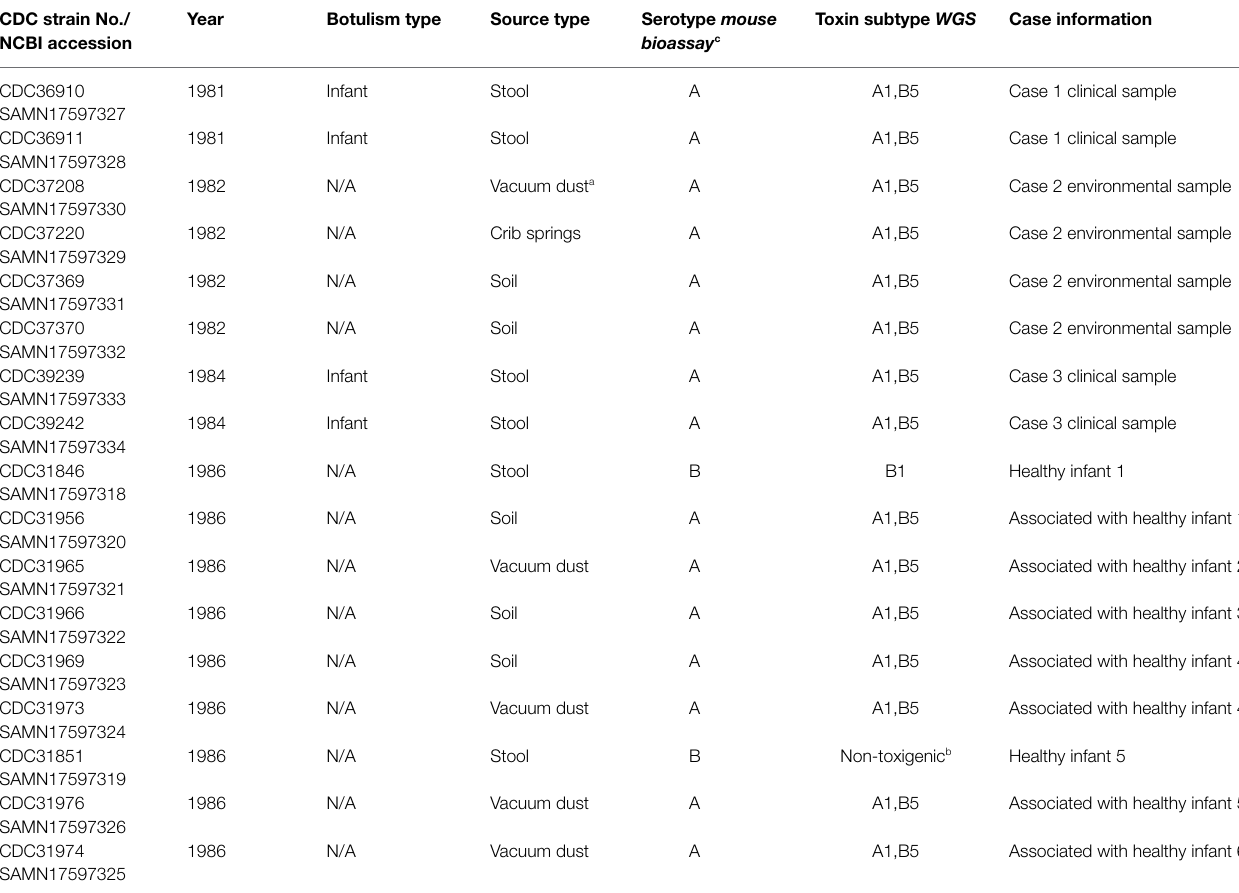
TABLE 1 | C. botulinum strains included in this study. CDC strain No./ NCBI